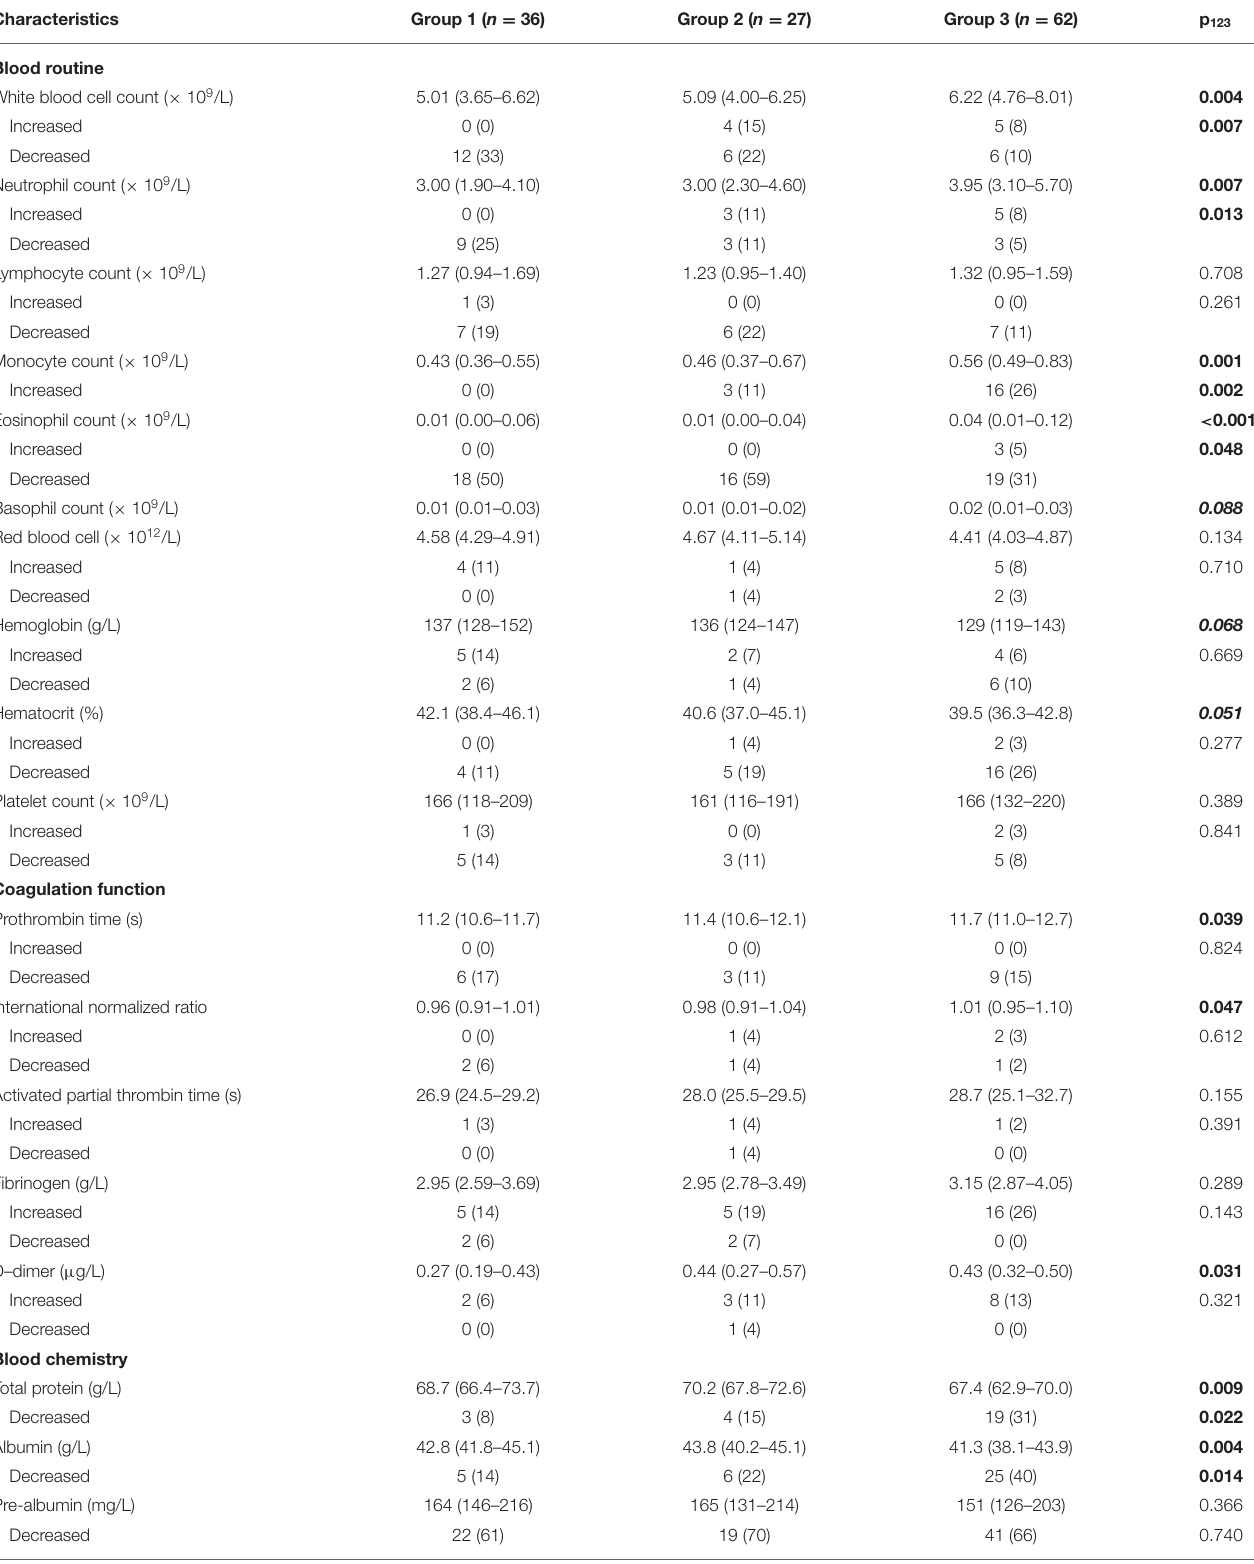
TABLE 2 | Laboratory features on